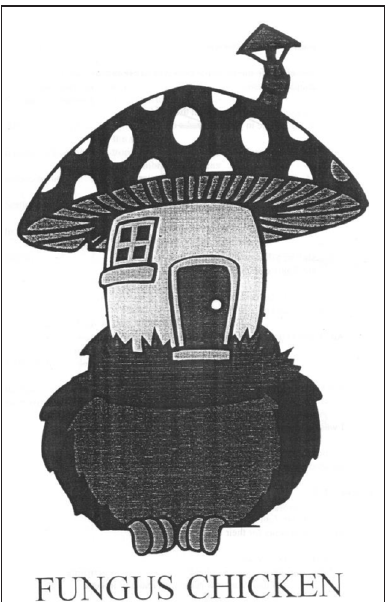
Figure 1: Image from me generation